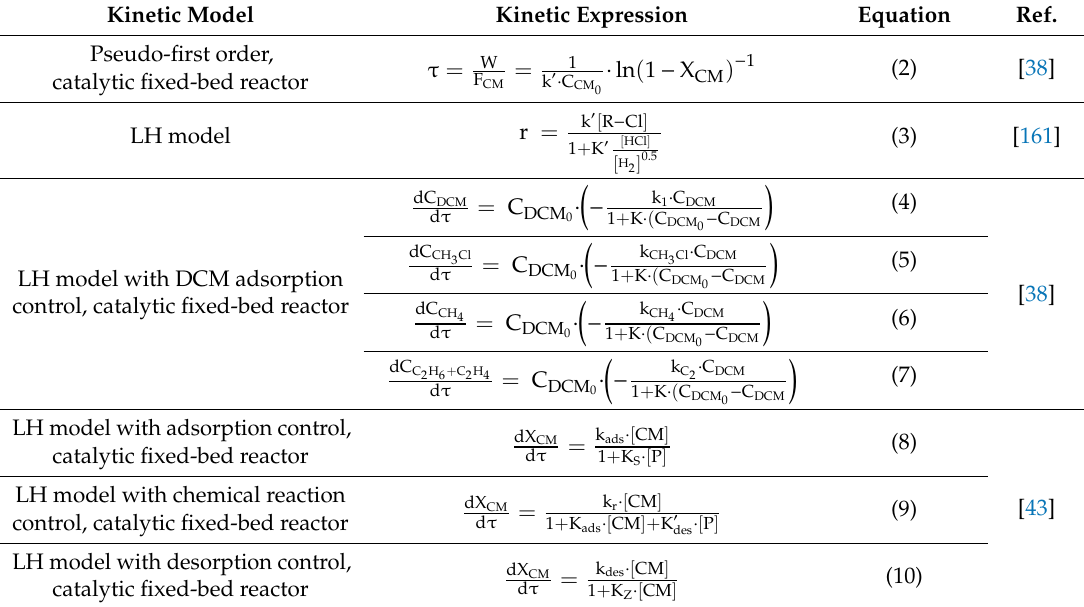
Table 1. Kinetic equations obtained from the application of the pseudo-first order or the LH models. Kinetic Model Kinetic Expression Equation Ref. Pseudo-first